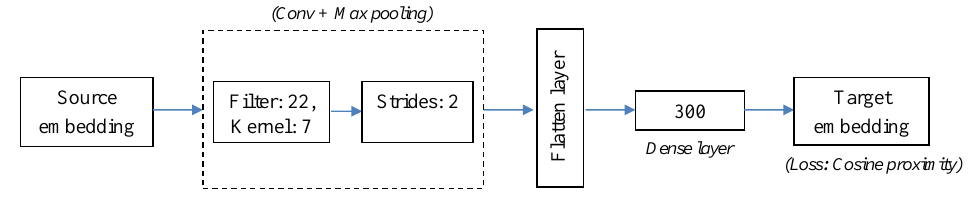
Figure 3. Architecture of